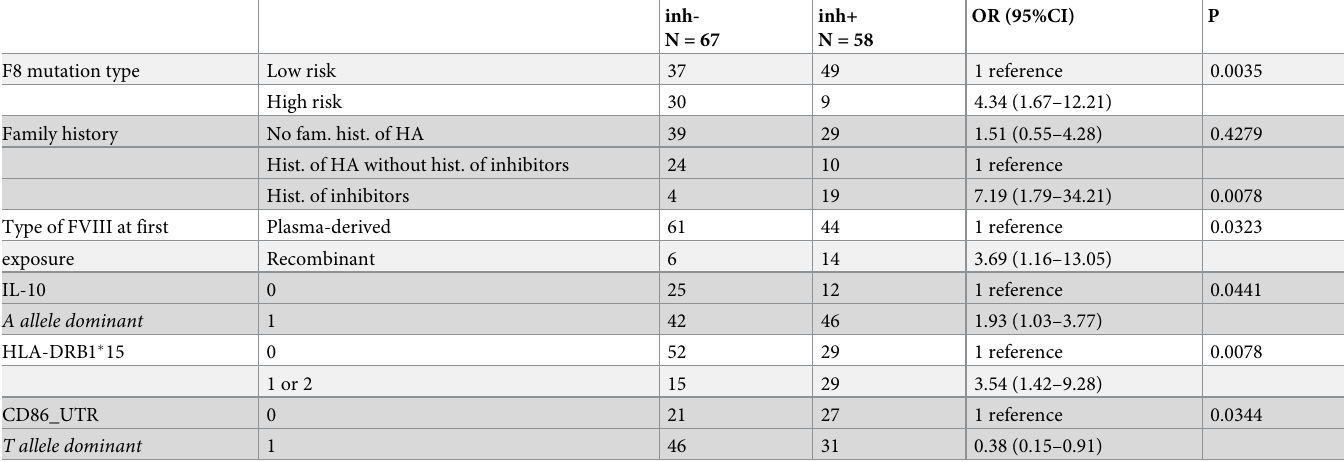
Table 4. Adjusted odds ratios for patient, disease, treatment and genetic risk factors for inhibitor